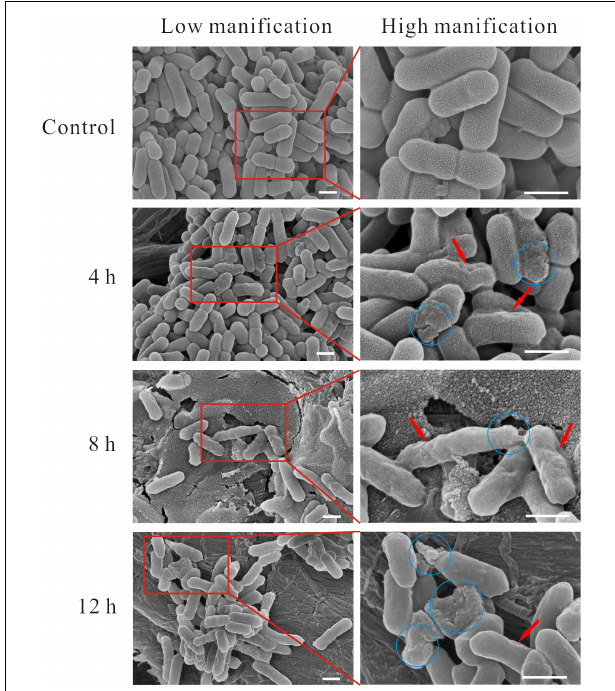
FIGURE 1 | SEM micrograph of L. monocytogenes planktonic cell treated and untreated with linalool. (Control) untreated bacteria; (4, 8, 12 h) bacteria treated with linalool at 1 × MIC for 4, 8, and 12 h respectively. Images on the right side are the magnification of the red rectangle in the left side. The red arrows indicated the wrinkled surface of cells, the blue circles indicated the lysis of cells, surface collapse and cell fragment. The scale bar represented 500